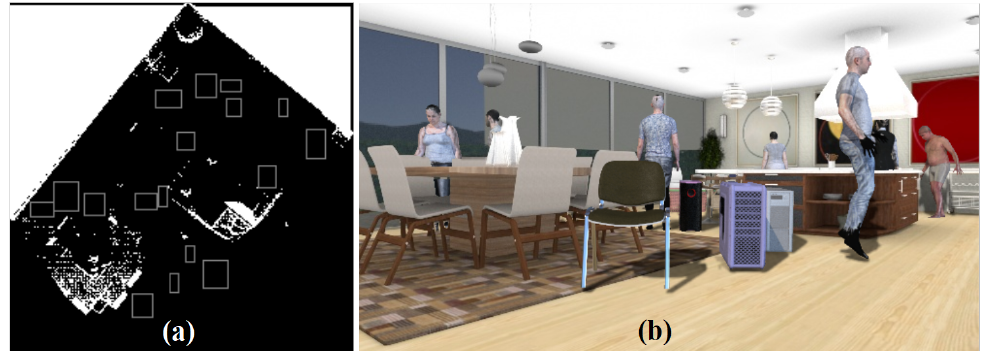
Figure 11. Example of the reconstructed occupancy map ( a ) and final image with embedded objects ( b ). Boxes show placeholders for the inserted